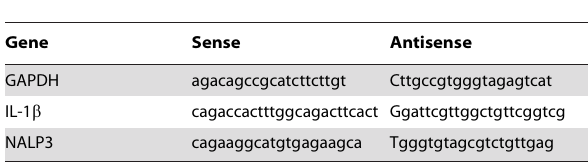
Table 1. Rat primers used for real-time RT-PCR.